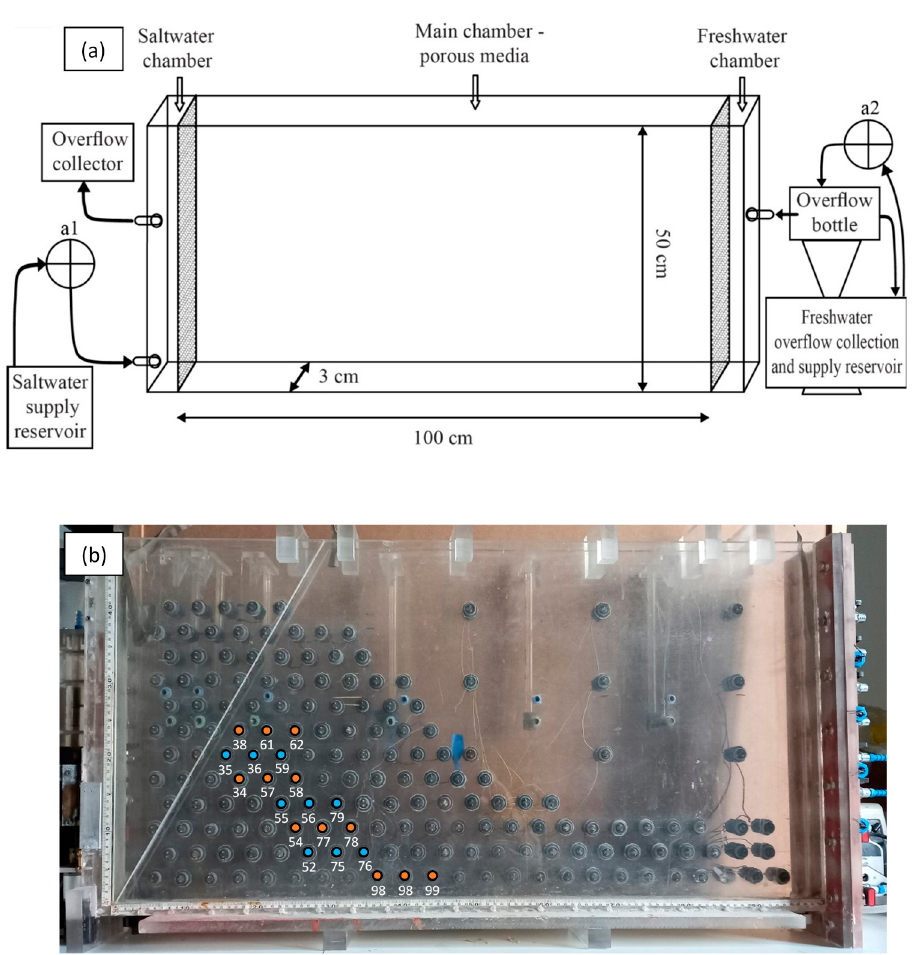
Figure 1. ( a ) A schematic description of the physical model. ( b ) A photo of the physical model and sensors. The colored (and numbered) sensors are those whose results are detailed in the text.